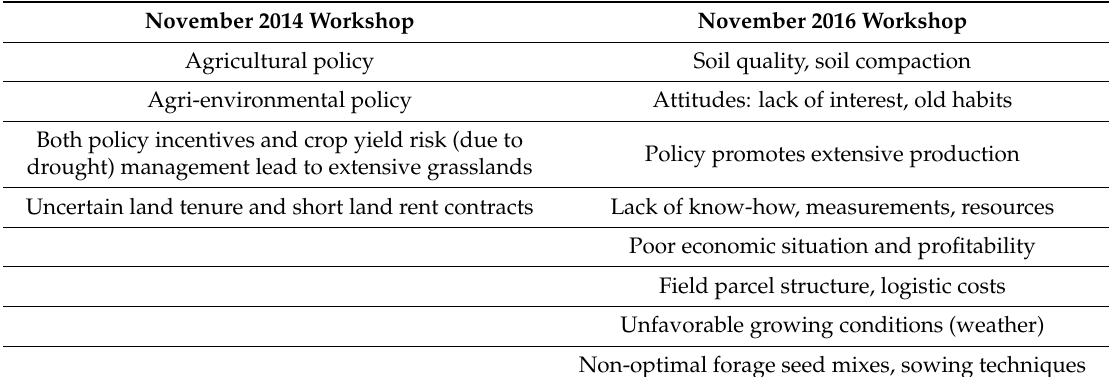
Table 2. Responses of farmers and close stakeholders to the question “What are the obstacles to achieving higher yields?” in the November 2014 and November 2016 workshops. The responses listed first were most frequently